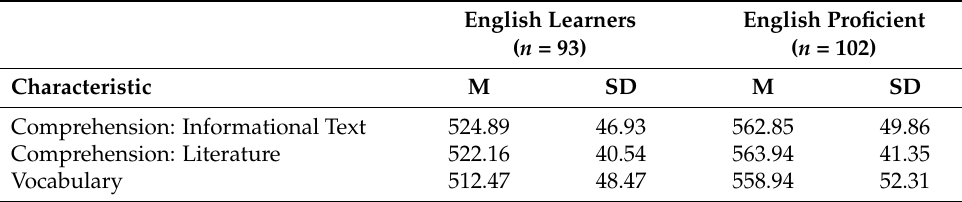
Table 2. Participant English Vocabulary and Reading Comprehension